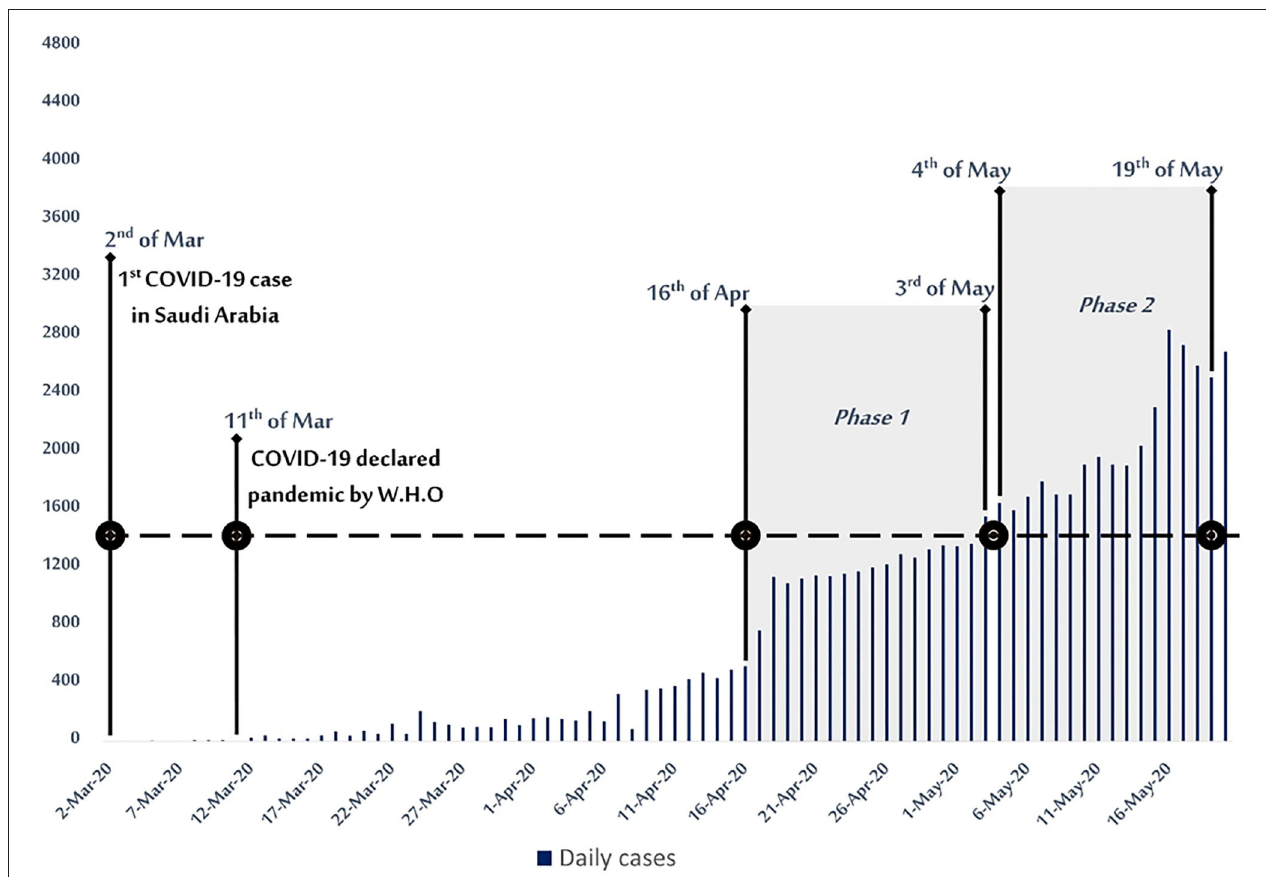
FIGURE 1 | COVID-19 epidemiological curve with active and community mass screening phases between 16 April- 19 May 2020 in Saudi